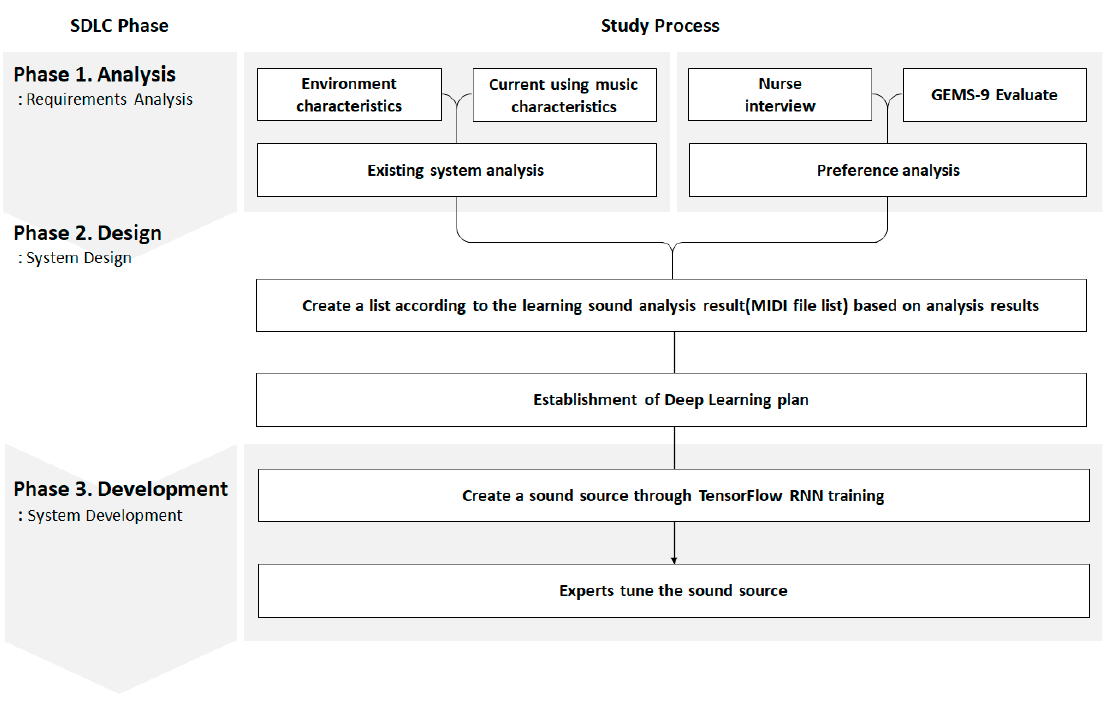
Figure 1. Study process regarding synthesizing music.